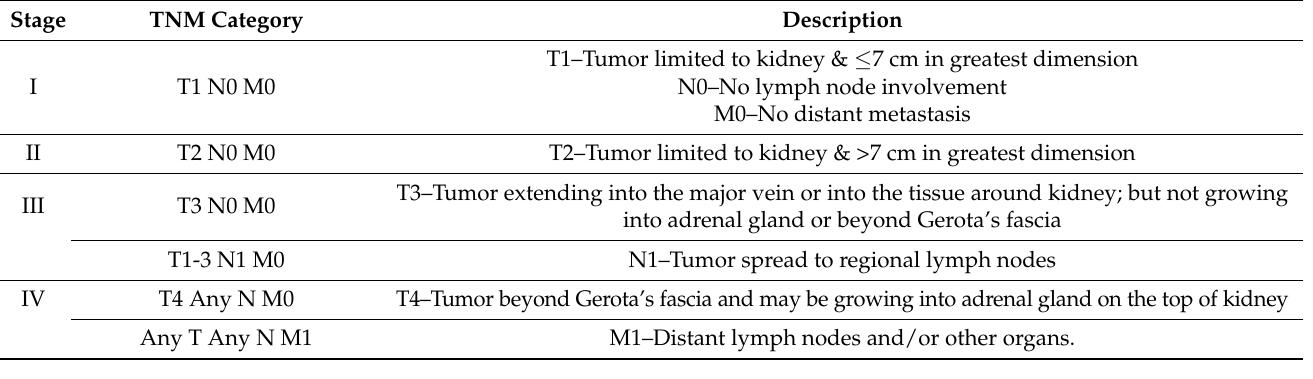
Table 3. AJCC staging of renal malignancies.